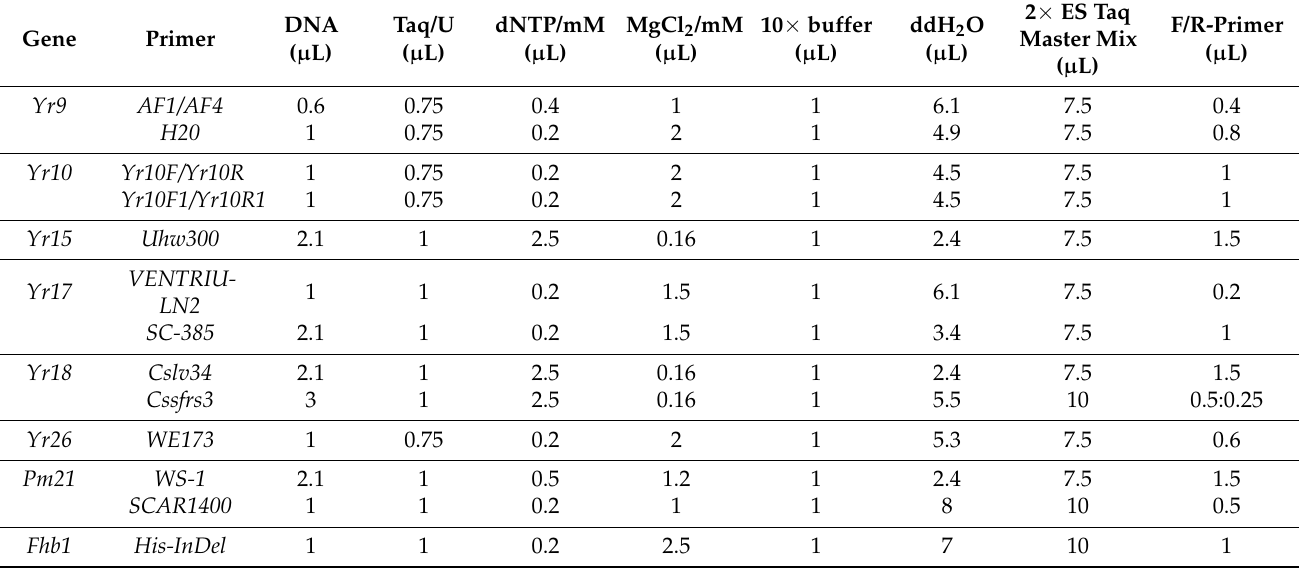
Table 2. The PCR reactions of different selected